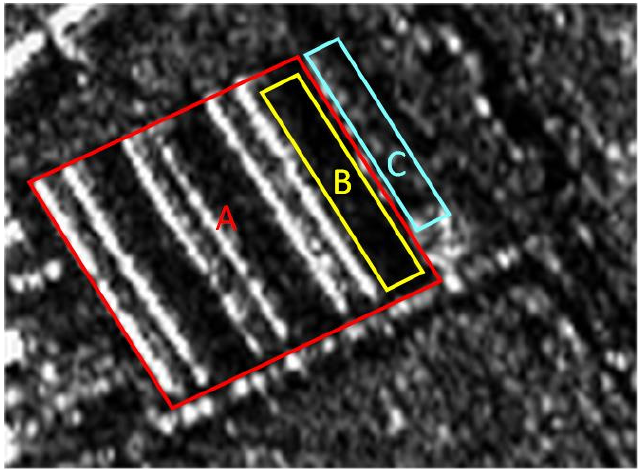
Figure 1. Trap region. Region A and B belong to one class, and Region C is another.